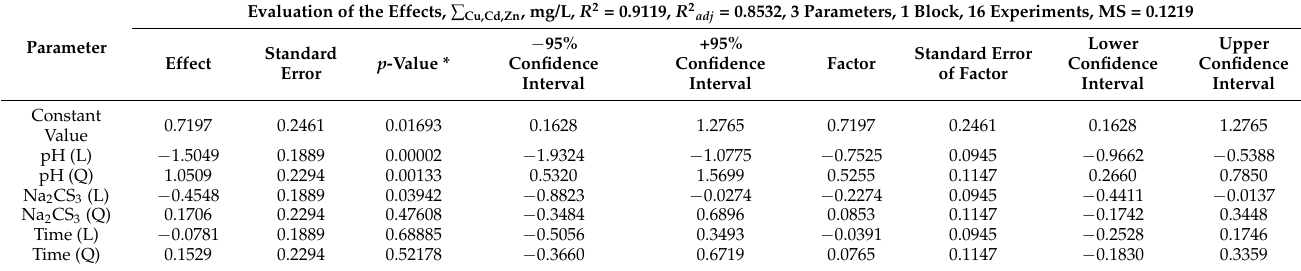
Table 4. Statistical parameters of the experiments using CCD/RSM—evaluation of the effects.